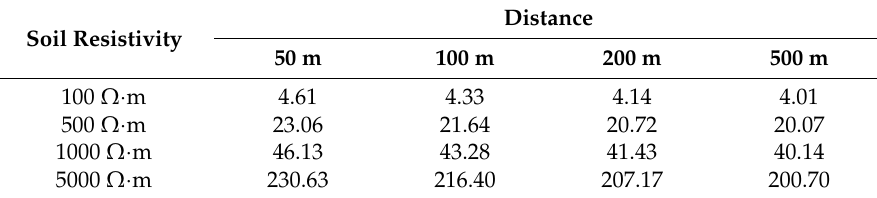
Table A3. Scenario 2a. Overall grounding resistance.